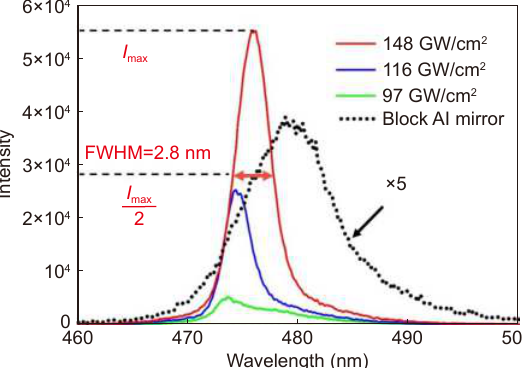
Fig. 16 | Spectra of stimulated emission output spectrum from polycrystalline ZnSe within the resonant cavity ( λ = 775 nm, τ = 200 fs). The solid lines and dotted line represent the spectrum within the cavity and with blocked high reflective mirror respectively.